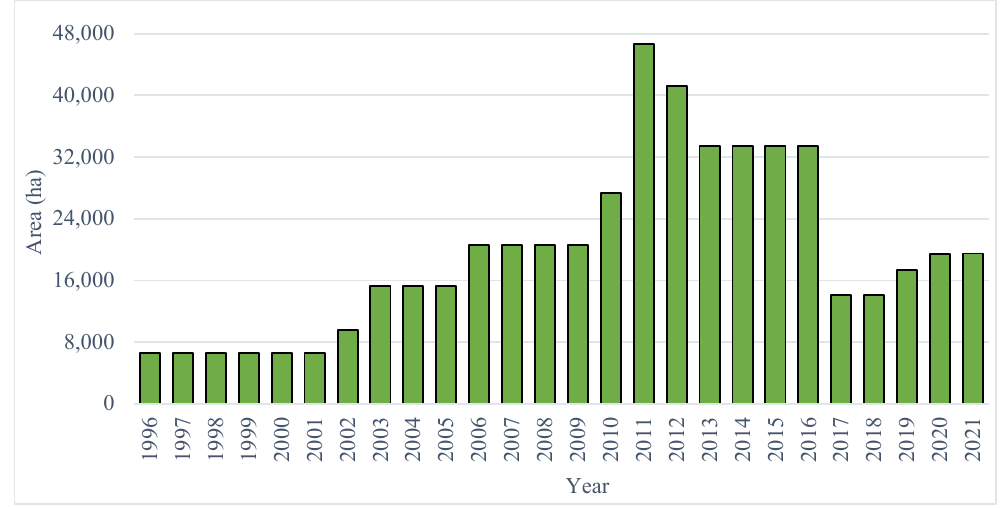
Figure 1. Growth of FSC certification in Sri Lanka (1996 to 2021). Source: [12].